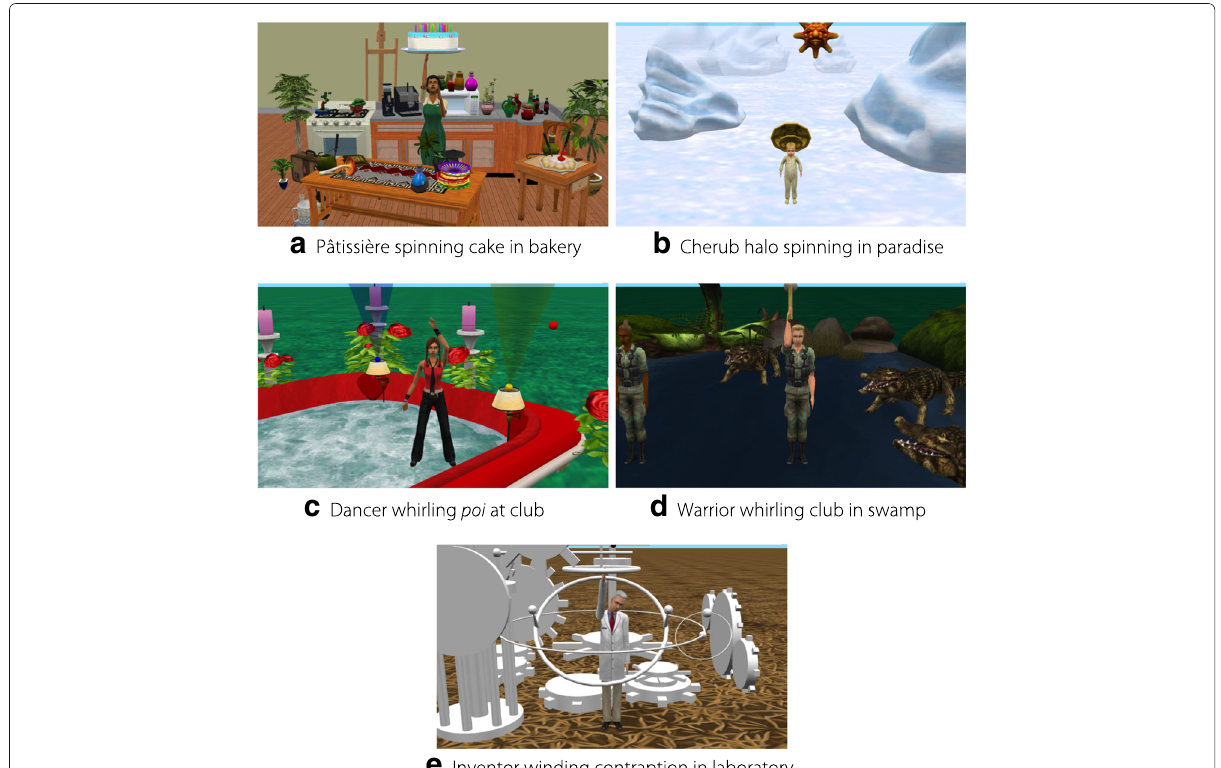
Fig. 13 Augmented virtuality twirling fantasy scenes, rigged for mobile affordance modulation (second generations of respective scenes)